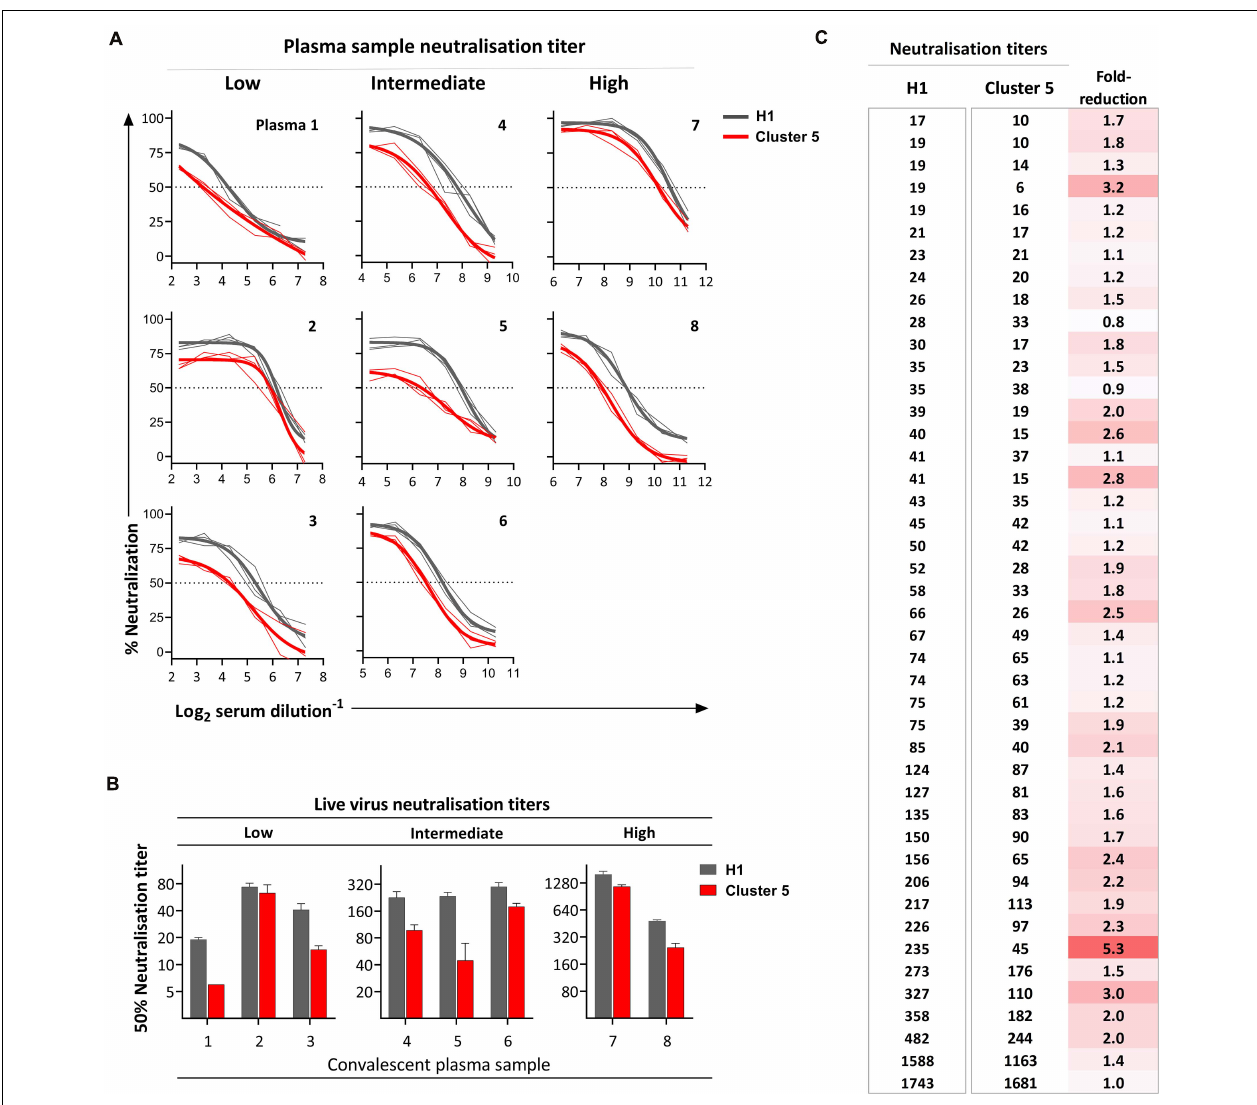
FIGURE 3 | Neutralization of the SARS-CoV-2 Cluster 5 virus relative to an early epidemic SARS-CoV-2 virus (H1). In all instances, neutralization was evaluated using live SARS-CoV-2 viruses isolated from clinical samples. (A) Neutralization activity of twofold serial diluted convalescent COVID-19 plasma was tested in triplicate with 300 × TCID 50 Cluster 5 or H1 virus. Thick lines represent the four-parameter titration curve calculated from the mean of triplicate measurements; thin lines represent each individual replicate. (B) The relative neutralization titres measured at 24 h post-inoculation for plasma samples for the individuals in (A) calculated as the interpolation of the four-parameter titration curve with the 50% cut-off value and presented as the reciprocal serum dilution. Bars represent the mean titre of triplicate measurements with the standard deviation. (C) Neutralization titres determined for 44 convalescent plasma from non-hospitalized individuals with PCR confirmed SARS-CoV-2 infection. Each line represents an individual plasma sample ranked by titre against the early pandemic strain.